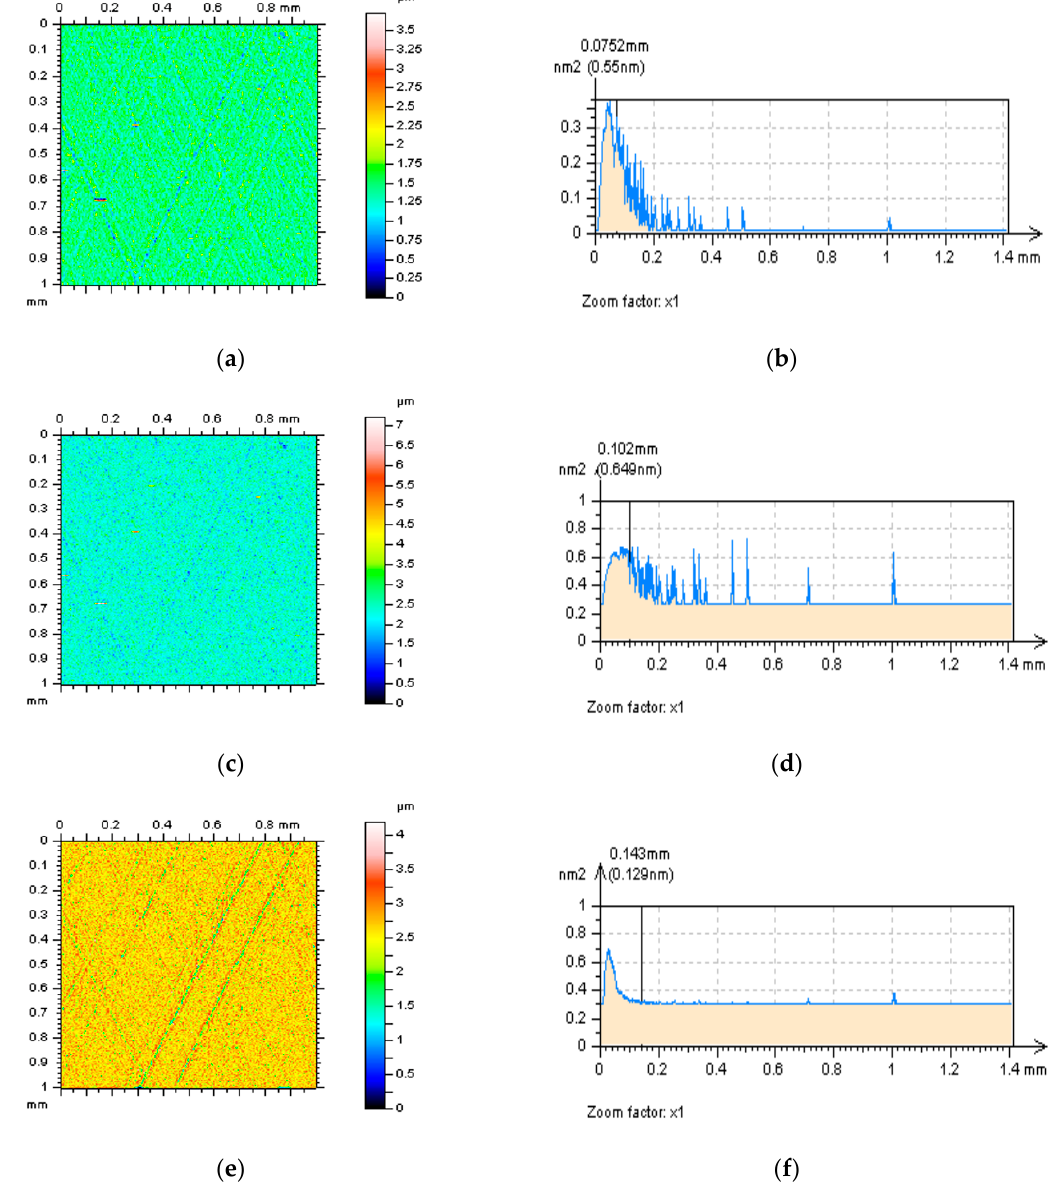
Figure 3. Examples of NS ( a , c , e ) and their PSDs ( b , d , f ) received from plateau-honed cylinder liner surface texture by application of GF ( a , b ), RGF ( c , d ) and SF ( e , f ), cut-off = 0.025 mm.